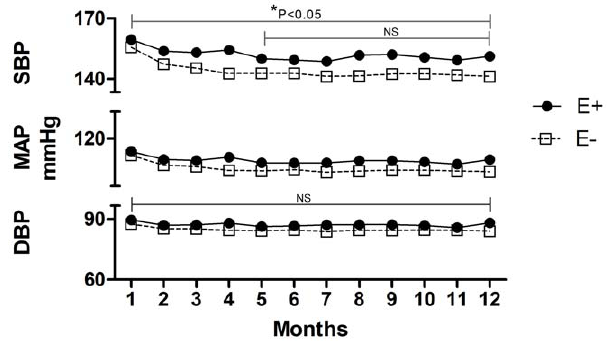
Figure 3. Systolic (SBP), Diastolic (DBP) and Mean Arterial Pressures (MAP) in incident PD patients during 12 months of follow up.